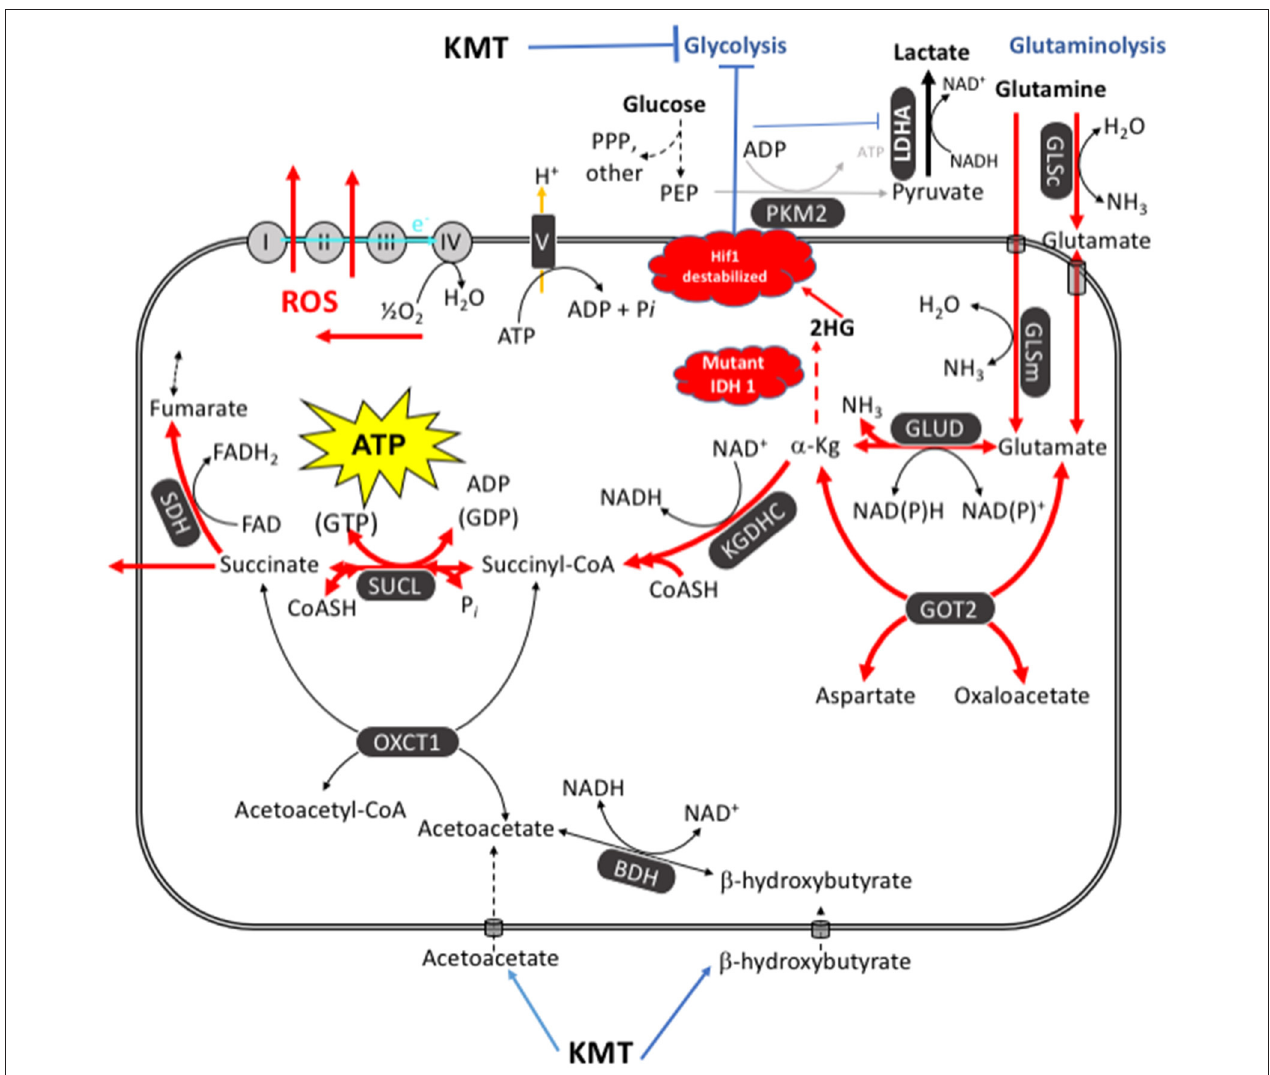
FIGURE 6 | KMT/ IDH1 synergistic interaction for targeting GBM energy metabolism. KMT can reduce glucose availability for glycolysis while also interfering with the glutaminolysis pathway. Glutamine-driven mitochondrial substrate-level phosphorylation (mSLP), in the glutaminolysis pathway, is a major source of ATP synthesis for GBM cells (25, 26). The glutaminolysis pathway (red) becomes dominant in tumor cells with inefficient OxPhos and that express the dimeric PKM2 isoform. PKM2 is expressed in GBM and produces less ATP through glycolysis than does the PKM1 isoform (109–111). The elevation of ketone bodies ( β -hydroxybutyrate and acetoacetate) through KMT could indirectly reduce ATP synthesis through the succinate CoA ligase (SUCL) reaction by diverting CoA from succinate to acetoacetate. The IDH1 mutation could further reduce ATP synthesis through mSLP by increasing synthesis of 2-hydroxyglutarate from α -ketoglutarate and thus reducing the succinyl CoA substrate for the SUCL reaction (26, 112). Besides its potential effect in reducing glutaminolysis, 2-hydroxyglutarate can also target multiple HIF1 α -responsive genes and enzymes in the glycolysis pathway thus limiting synthesis of metabolites and one-carbon metabolism needed for rapid tumor growth (25, 26, 103, 113). The down-regulation of Hif1- α -regulated lactate dehydrogenase A (LDHA), through the action of both KMT and the IDH1 mutation, would reduce extracellular lactate levels thus reducing microenvironment inflammation and tumor cell invasion. Hence, the simultaneous inhibition of glycolysis and glutaminolysis through the synergistic effects of KMT and the IDH1 mutation will stress the majority of signaling pathways necessary for rapid GBM growth. BDH, β -hydroxybutyrate dehydrogenase; FAD, flavin adenine dinucleotide; GLSc, glutaminase, cytosolic; GLSm, glutaminase; mitochondrial; GLUD, glutamate dehydrogenase; GOT2, aspartate aminotransferase; KGDHC, α -ketoglutarate dehydrogenase complex; LDHA, lactate dehydrogenase A; NME, nucleoside diphosphate kinase; OXCT1, succinyl-CoA:3-ketoacid coenzyme A transferase 1; PC, pyruvate carboxylase; PDH, pyruvate dehydrogenase; PEP, phosphoenolpyruvate; PKM2, pyruvate